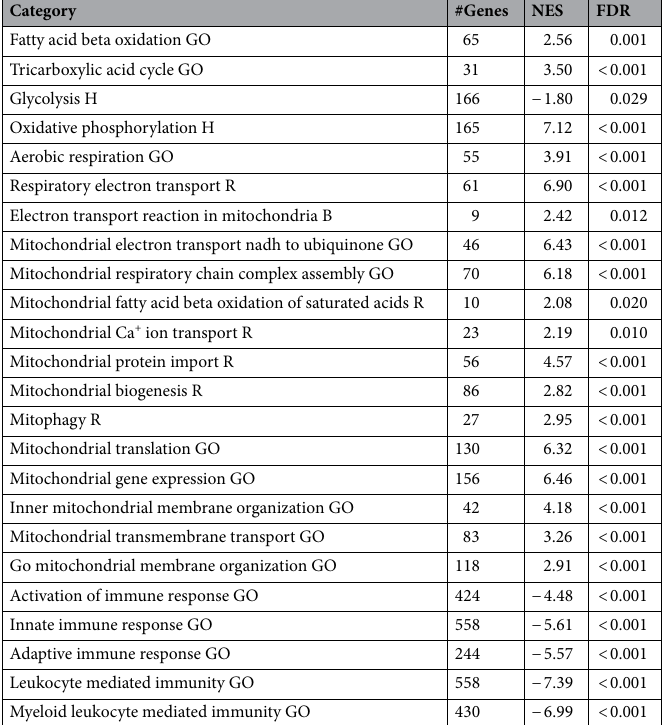
Table 2. Gene set enrichment for selected Gene Ontology (GO) biological processes, Hallmark (H), Reactome (R) and KEGG (K) sets involved in metabolism, mitochondrial oxidation and biogenesis, and immunity in bone of black bears during hibernation. Positive NES (normalized enrichment score) values indicate elevated proportion of overexpressed genes and negative scores indicate excess of under expressed genes during hibernation relative to summer. FDR is the false discovery rate.